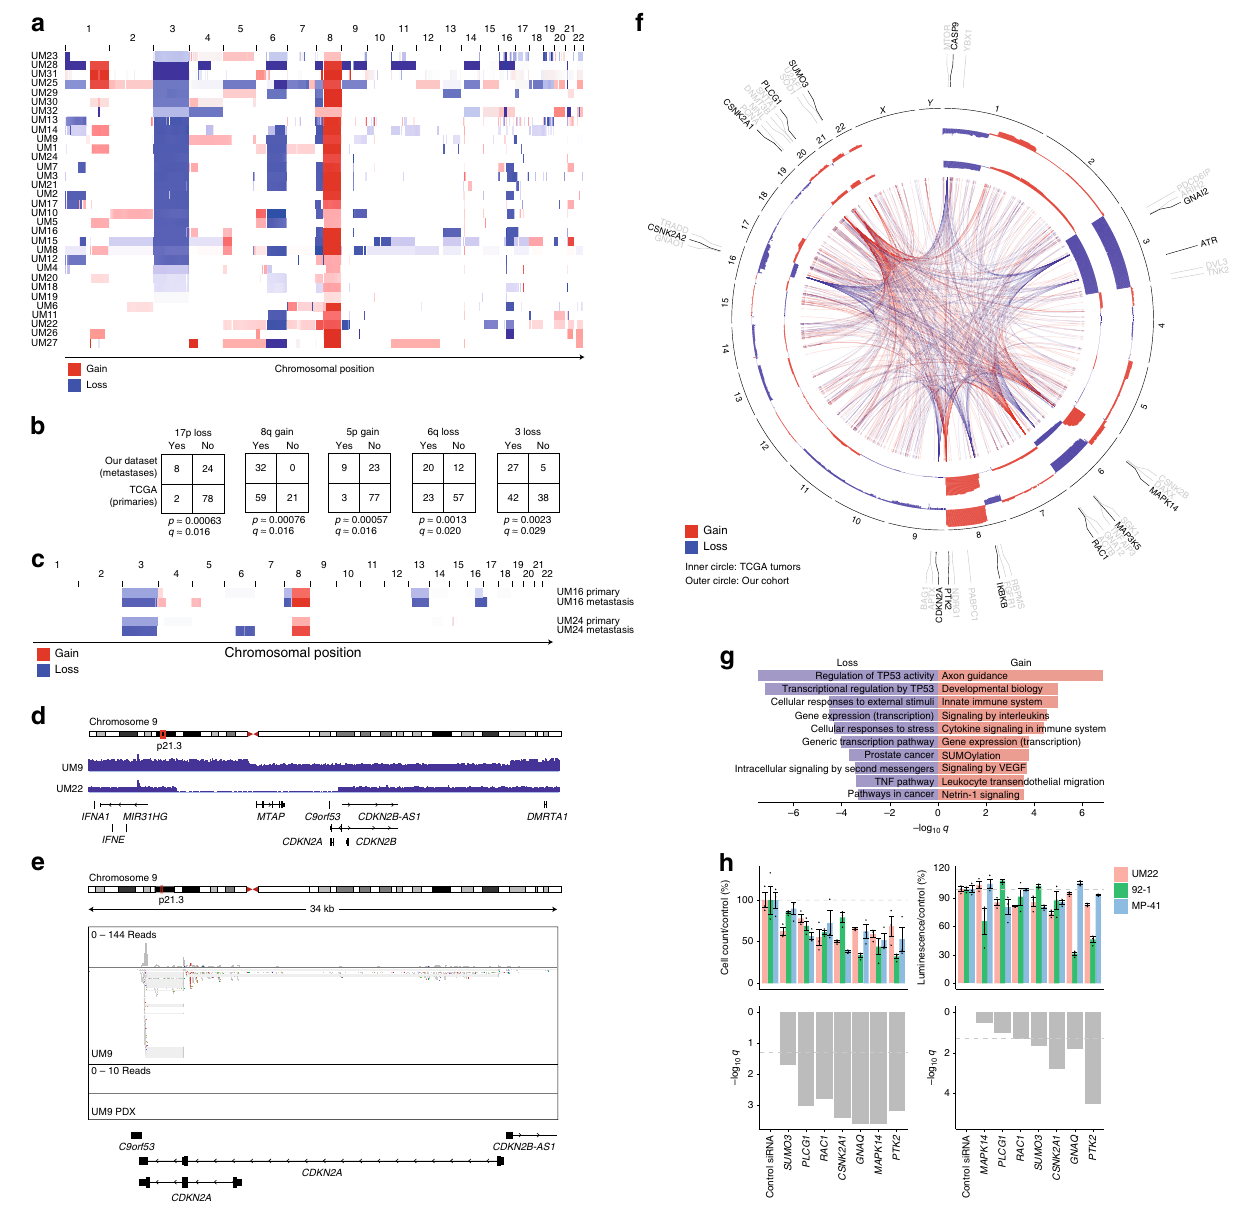
Fig. 2 Copy number analysis. a Copy number pro fi les of each tumor. Differences in color intensity depend on copy number amplitude and tumor purity. b Broad copy number changes enriched in the metastases ( n = 32) compared with TCGA tumors ( n = 80). Two-tailed Fisher ’ s exact tests with adjustment for multiple testing using the Benjamini – Hochberg method. c Two primary tumors compared with matched metastases. d Focal deletions of CDKN2A in two samples. e RNA-seq from the UM9 metastasis and corresponding PDX showing the region with focal CDKN2A deletion. f Genes in recurrent arm-level copy number aberrations ranked by associations between gene expression and copy number that were consistent in this cohort and TCGA tumors, and further ranked by protein – protein interaction network degree from the Human Protein Reference Database (HPRD), and additionally by presence of any associations with worse survival. The top three candidates are shown in each region. Connecting lines represent protein interactions of the highest ranked gene per region. Blue represents regions of loss and red regions of gain. Summarized representations of copy number pro fi les per region show the relative numbers of gain and loss events, with the inner circle representing TCGA samples and the outer our cohort. For the metastatic cohort, n = 28 samples with matching DNA and RNA data were included. g Pathways enriched among the combined set of the top 10 genes per region of gain or loss. h Functional interrogation by siRNA of main candidate genes whose expression is elevated due to copy number alteration. Cells were counted or viability was measured at 72 h, 96 h and 96 h for the cell lines UM22, MP-41, and 92-1, respectively, after transfection of the siRNA pools. n = 3 samples were transfected independently, for each cell line. Data are presented as mean values ± standard error of the mean (SEM). Two-way ANOVA was used to estimate differences, taking into account both cell line and target gene as variables. q values were calculated using Benjamini – Hochberg correction, taking into account all genes in h as well as those in Supplementary Fig. 3c, which shows other candidates of interest investigated. Dotted lines indicate q =